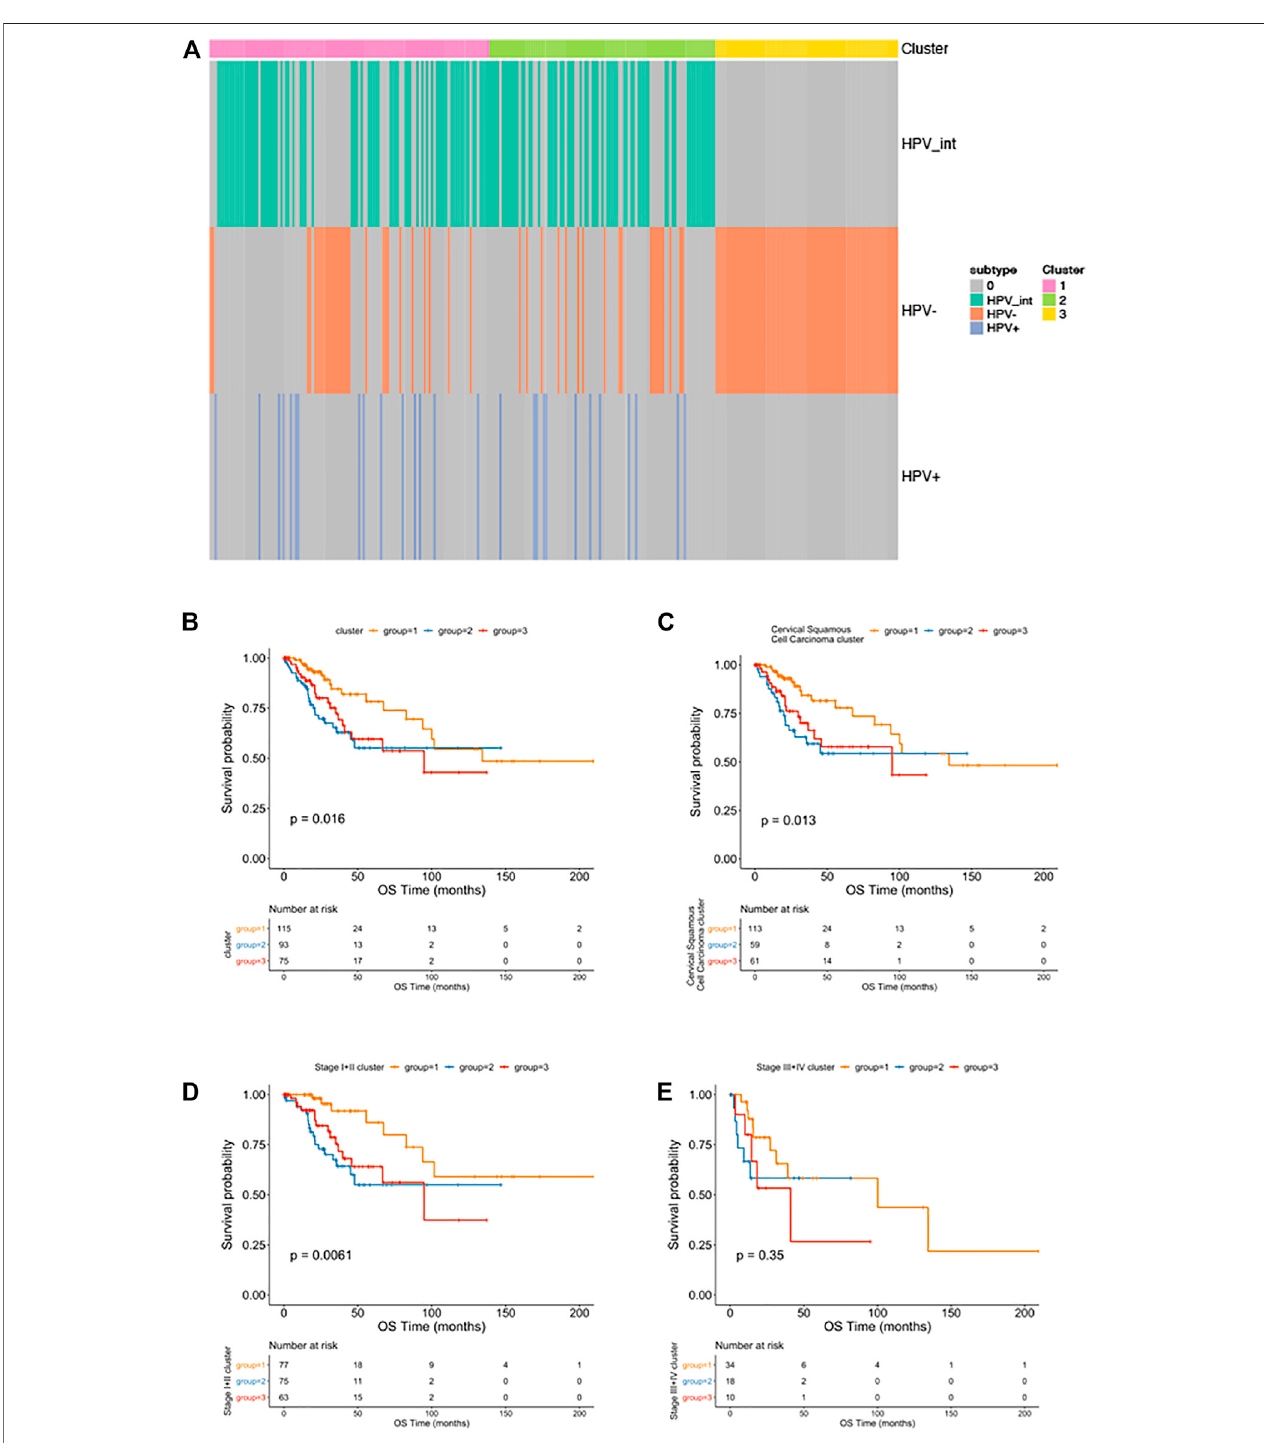
FIGURE 4 | Multi-omics clustering analysis. (A) : The cluster-of-clusters analysis separated cervical cancers into three subgroups; (B – D) : Kaplan-Meier analysis of overallsurvivalstrati fi edbythreesubgroupsamongallcervicalcancerpatients (B) ;amongsquamouscervicalcancerpatients (C) ;amongpatientswithstageI-IIcervical cancers (D) and stage Ⅲ - Ⅳ cervical cancers (E) .